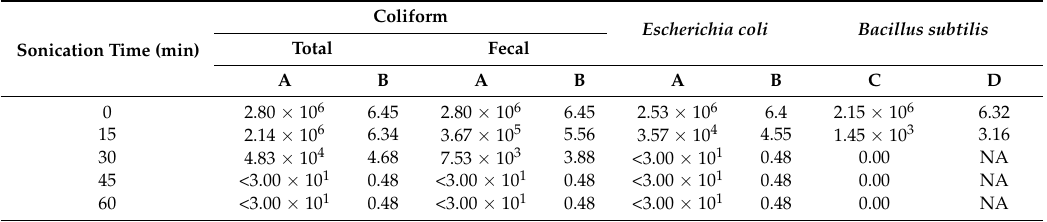
Table 3. Microorganism average concentration according to ultrasound application at different times.